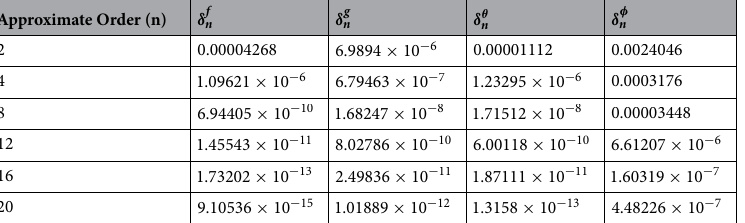
Approximate Order